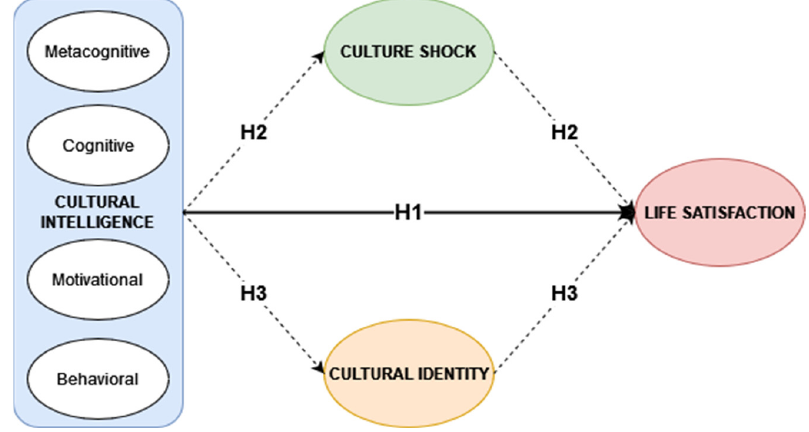
Figure 1. Conceptual framework (Source: own construction).